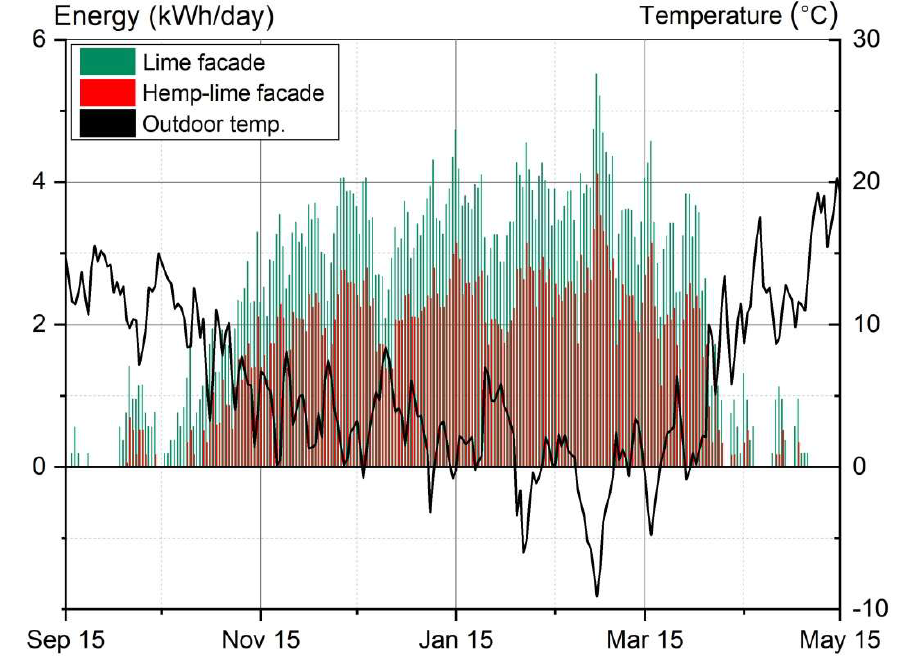
Figure 13. Energy use per day for room A (lime wall) and B (hemp-lime wall) as well as average daily outdoor temperature, from 15 September 2017 to 15 May 2018.